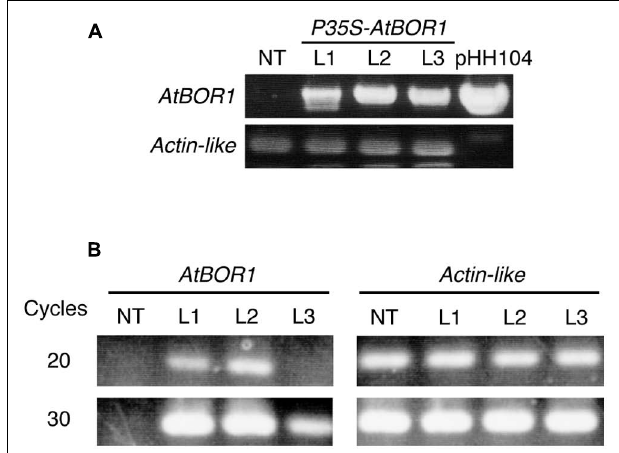
FIGURE 1 | Establishment of transgenic tomato expressing AtBOR1 . (A) Genomic DNA was extracted from non-transgenic (NT) and regenerated T 0 plants (L1, L2, and L3). PCR was performed using genomic DNA as a template with primers specific to theT-DNA or tomato Actin -like gene. pHH104 was also used as a control forT-DNA. (B) Total RNA was extracted from the roots of non-transgenic plants (NT) and transgenicT1 plants (L1, L2, and L3). Semiquantitative RT-PCR was performed using primers specific to AtBOR1 or the Actin -like